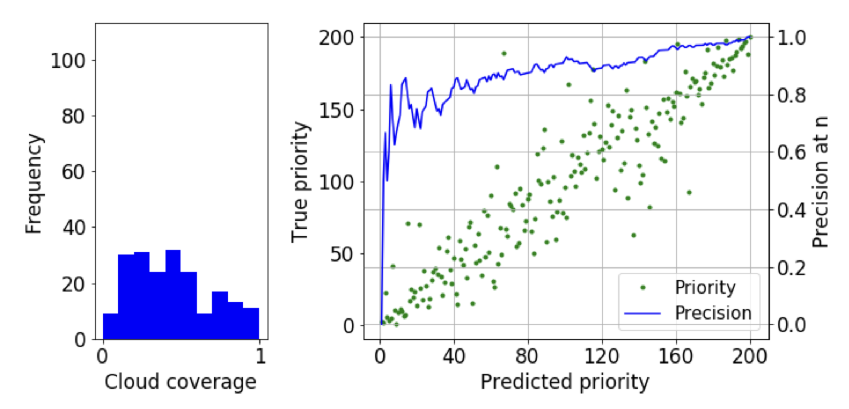
Figure 11. Prioritization result for balanced dataset. Spearman’s rank correlation coefficient ρ = 0.977.